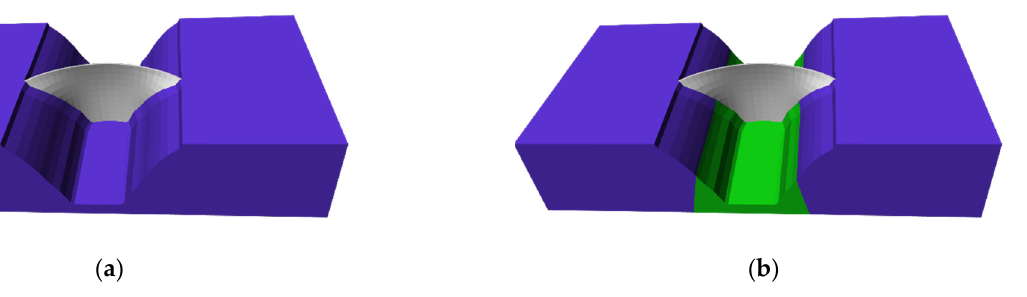
Figure 2. Sectorization of the model: ( a ) two moduli of elasticity: grey for the dam (E 1 ) and blue for the homogeneous foundation (E 2 ); ( b ) three moduli of elasticity: grey for the dam (E 1 ), blue for both abutments (E 2 ), and green for the riverbed (E 3 ).